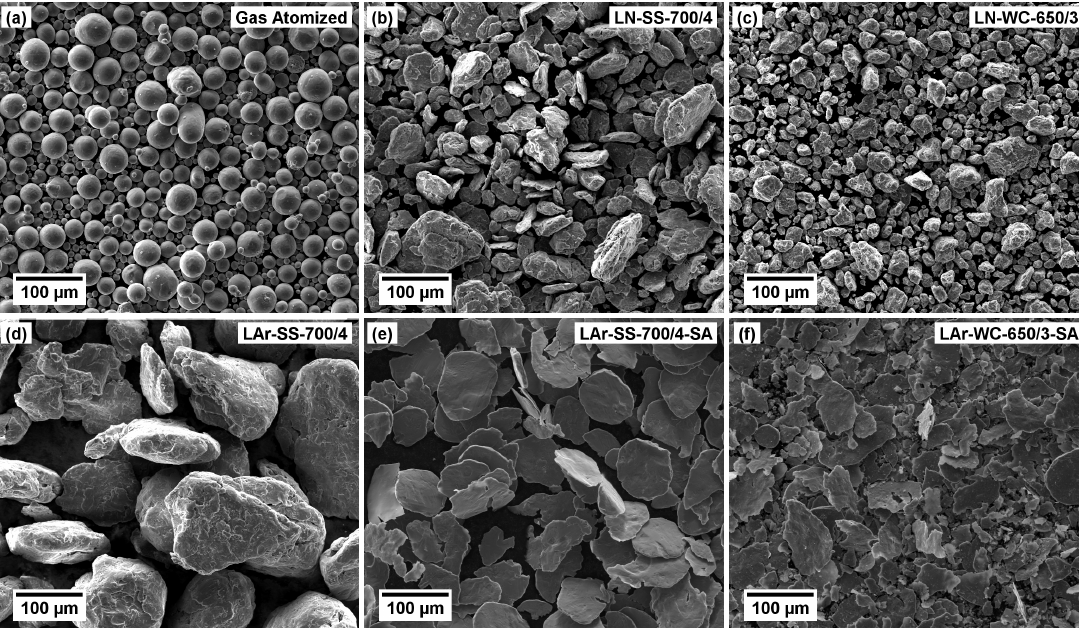
Figure 1. SEM micrographs of powders: ( a ) gas-atomized; ( b ) LN, SS balls, 4 h; ( c ) LN, WC-Co balls, 3.25 h; ( d ) LAr, SS balls, 4 h; ( e ) LAr, SS balls, 4 h, with SA; ( f ) LAr, WC-Co balls, 3.25 h, with SA.